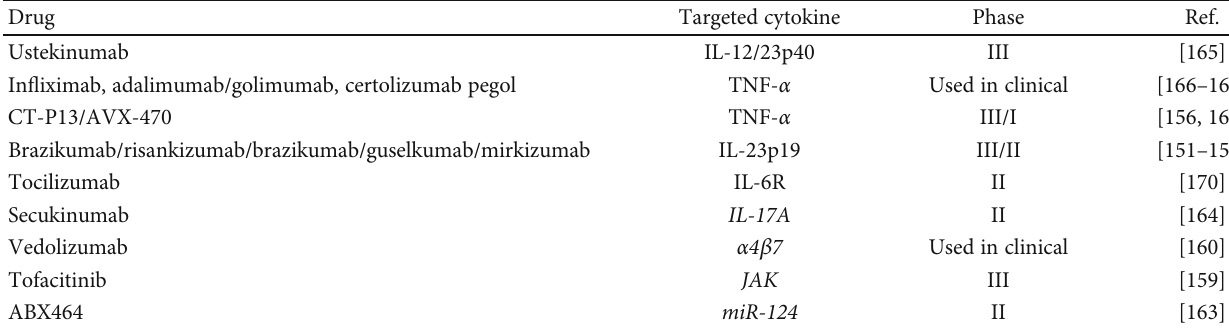
Table 1: Therapies targeting Th17 cells in